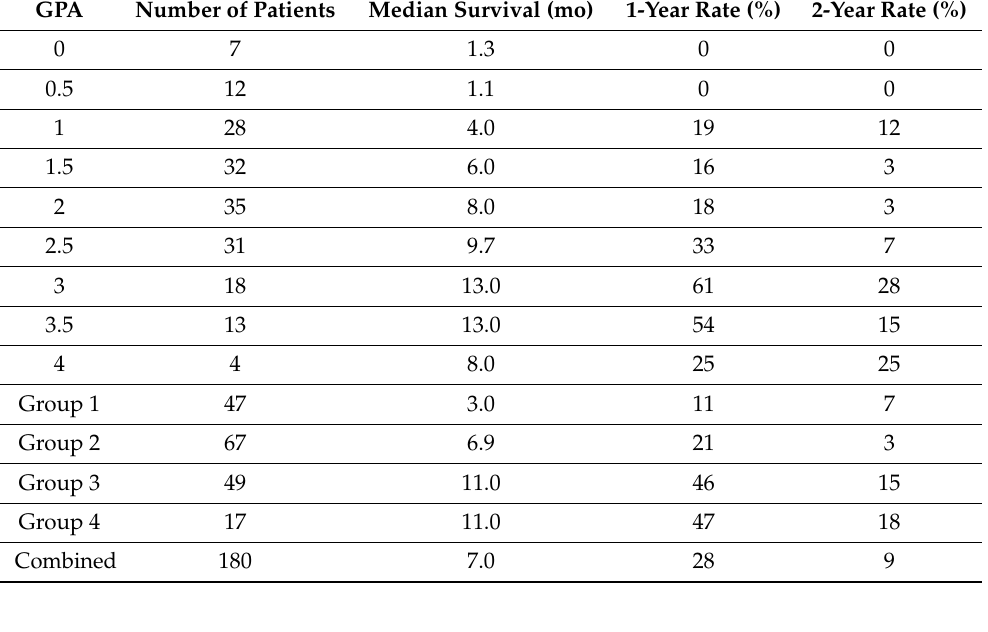
Table 3. Graded prognostic assessment (GPA) and actuarial survival ( n = 180, Kaplan-Meier analysis).